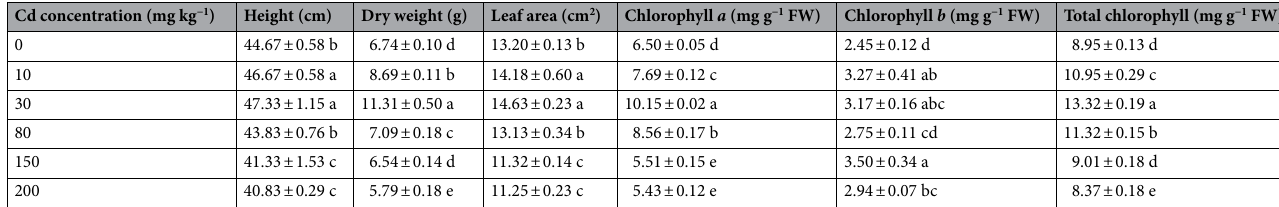
Table 1. Effects of different concentrations of cadmium on growth parameters and chlorophyll content in Lonicera japonica Thunb. after 90 days. Different letters indicate a significant difference ( P < 0.05) based on Duncan’s multiple range test at 5% level. Values are the mean ± SD (n =